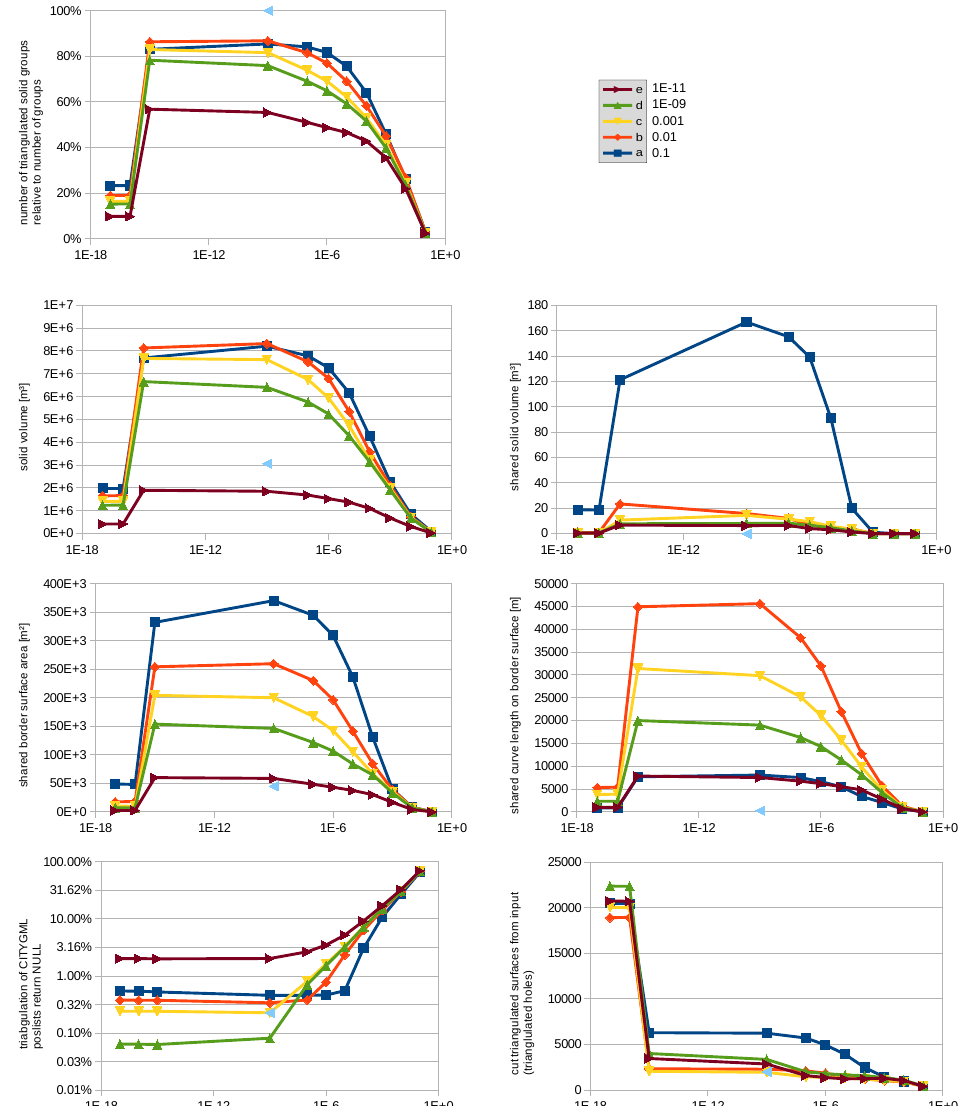
Figure 9. Results of city centre of Erfurt, second decomposition type. The dataset is decomposed into several groups, where each group consists of one building together with its parts. ( x -axis: angular precision ζ , different colours for each precision (cid:101) = ε = σ = λ